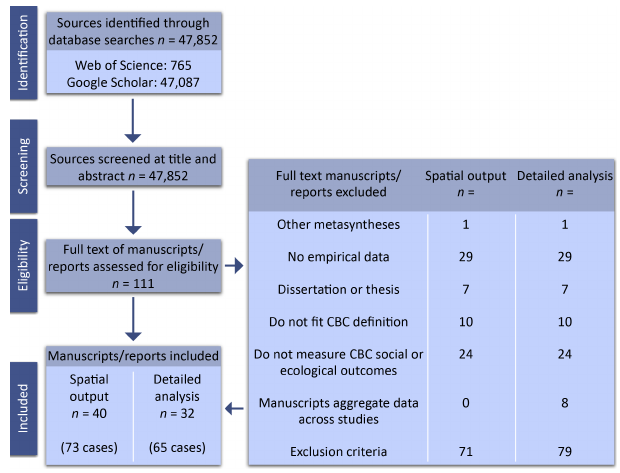
Fig. 2 . Flow chart illustrating the process of choosing community-based conservation (CBC) studies for inclusion in the review (adapted from McKinnon et al. 2016). Potential sources were identified through Web of Science and Google Scholar database searches of key CBC institution terms ( n = 47,852). This initial pool of manuscripts and reports was further screened by the title and abstract for inclusion in the full text review ( n = 111). The final number of cases included in the spatial analysis and detailed analysis were 73 and 65,